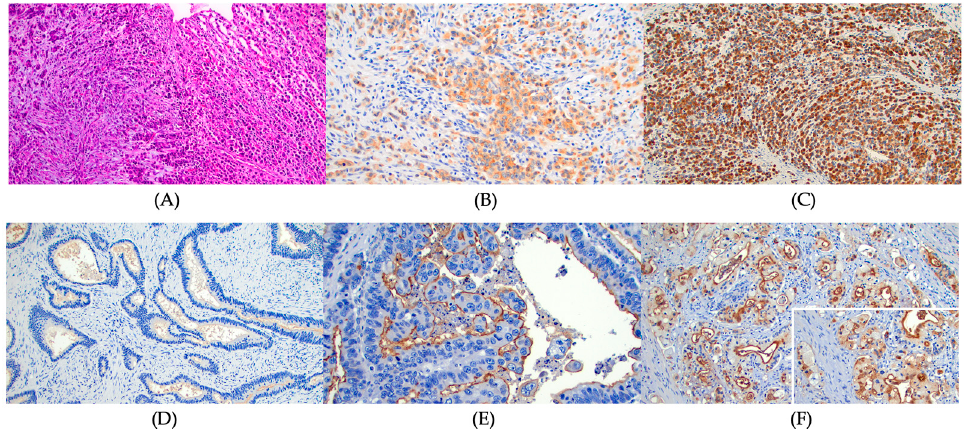
Figure 1. The immunohistochemical (IHC) stain for mucin expression. ( A ) Diffuse signet ring cell gastric carcinoma. Hematoxylin and Eosin stain, × 100, ( B ) MUC 1 focal cytoplasmic staining, 2+ intensity, diffuse signet ring cell gastric carcinoma. MUC 1 IHC, × 200, ( C ) MUC 1 diffuse and strong cytoplasmic staining, 3+ intensity, diffuse signet ring cell gastric carcinoma. MUC 1 IHC, × 100, ( D ) No staining of MUC1, intestinal type gastric carcinoma. MUC 1 IHC, × 200, ( E ) MUC 1 strong luminal staining only, 3+ intensity, intestinal type gastric carcinoma. MUC 1 IHC, × 200, and ( F ) MUC 1 luminal and focal cytoplasmic staining, 3+ intensity, intestinal type gastric carcinoma. MUC 1 IHC, × 200. Inset: higher magnification to show luminal and cytoplasmic staining, ×